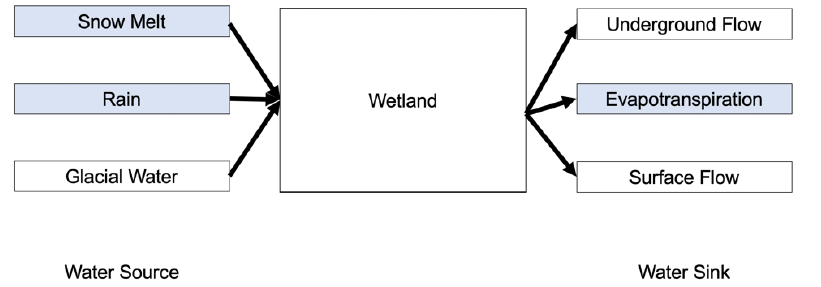
Figure 3. A simplified diagram of water sources and water sink in our study. The boxes marked in blue are factors estimated in this study.